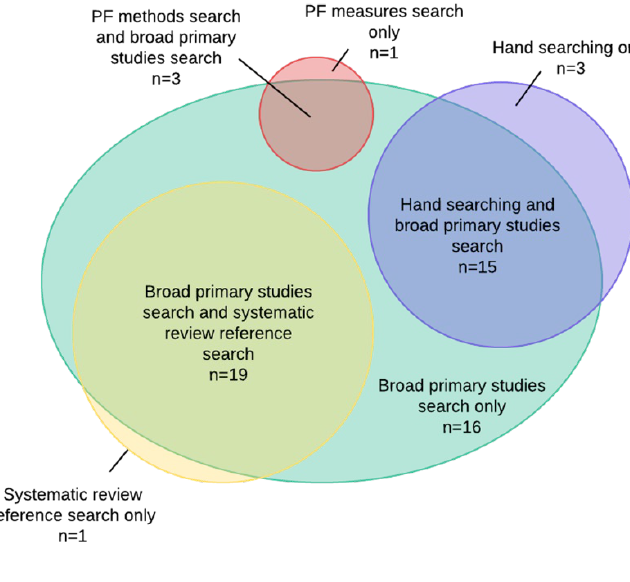
Figure 3 Visualization of overlap in recall of each search component used in Hayden et al.’s review [28], substituting the focused electronic database search for primary studies with a hypothetical broad electronic search*